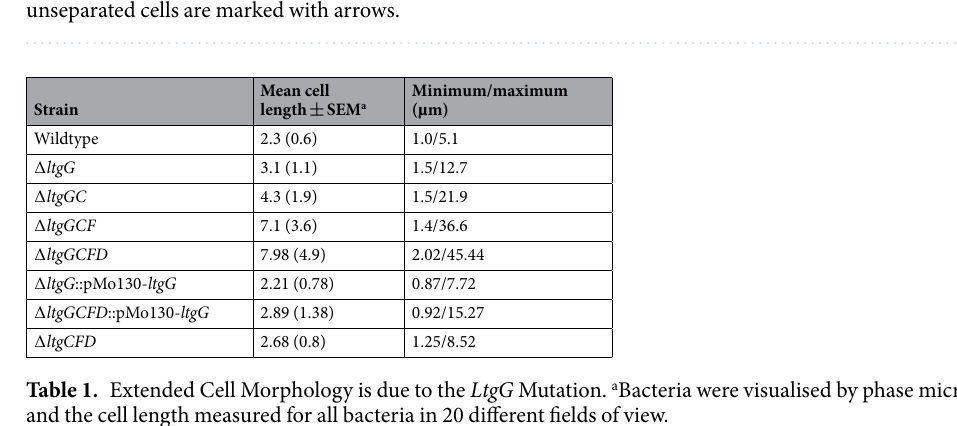
Table 1. Extended Cell Morphology is due to the LtgG Mutation. a Bacteria were visualised by phase microscopy and the cell length measured for all bacteria in 20 different fields of